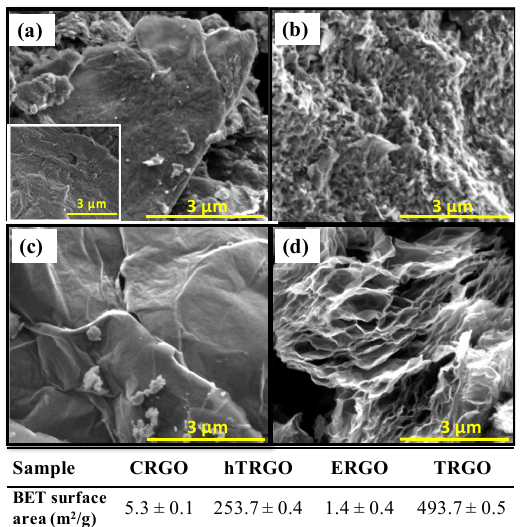
Figure 4. SEM images obtained for ( a ) CRGO; ( b ) hTRGO; ( c ) ERGO; and ( d ) TRGO. Scale bar: 3 µm. Inset image ( a ) SEM of the starting GO. Table below is the data of specific surface area.